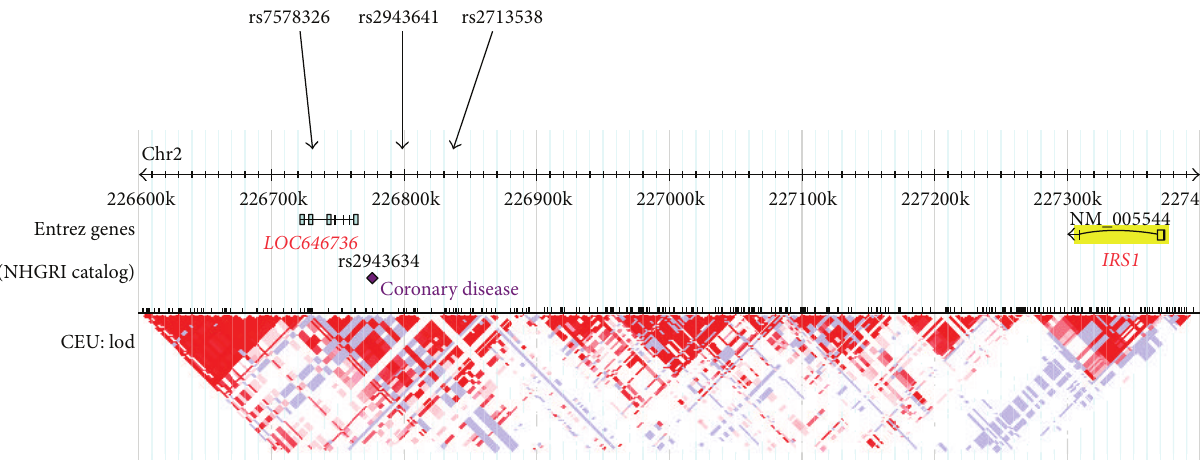
Figure 1: Location of typed SNPs relative to IRS1 and LOC646736 . Haplotype blocks are shown in the lower half of the figure (HapMap Data Phase III/Rel #2, February 2009, on NCBI B36 assembly, dbSNP b126, CEU population).